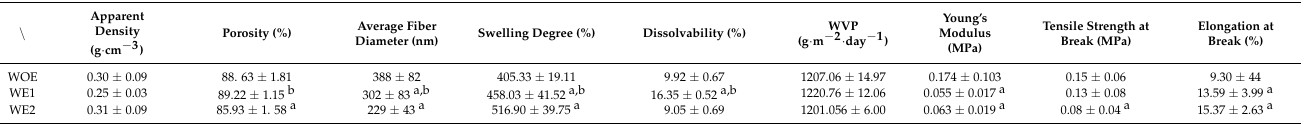
Table 1. Properties of produced electrospun meshes. Mechanical properties correspond to tests performed on the wet state. Statistical significance for p ≤ 0.05 using t -test, n = 5 (with the exception for mechanical tests n = 15). a Have statistical significance when compared to control ( p ≤ 0.05). b Have statistical significance when compared to 2 wt% of extract ( p ≤